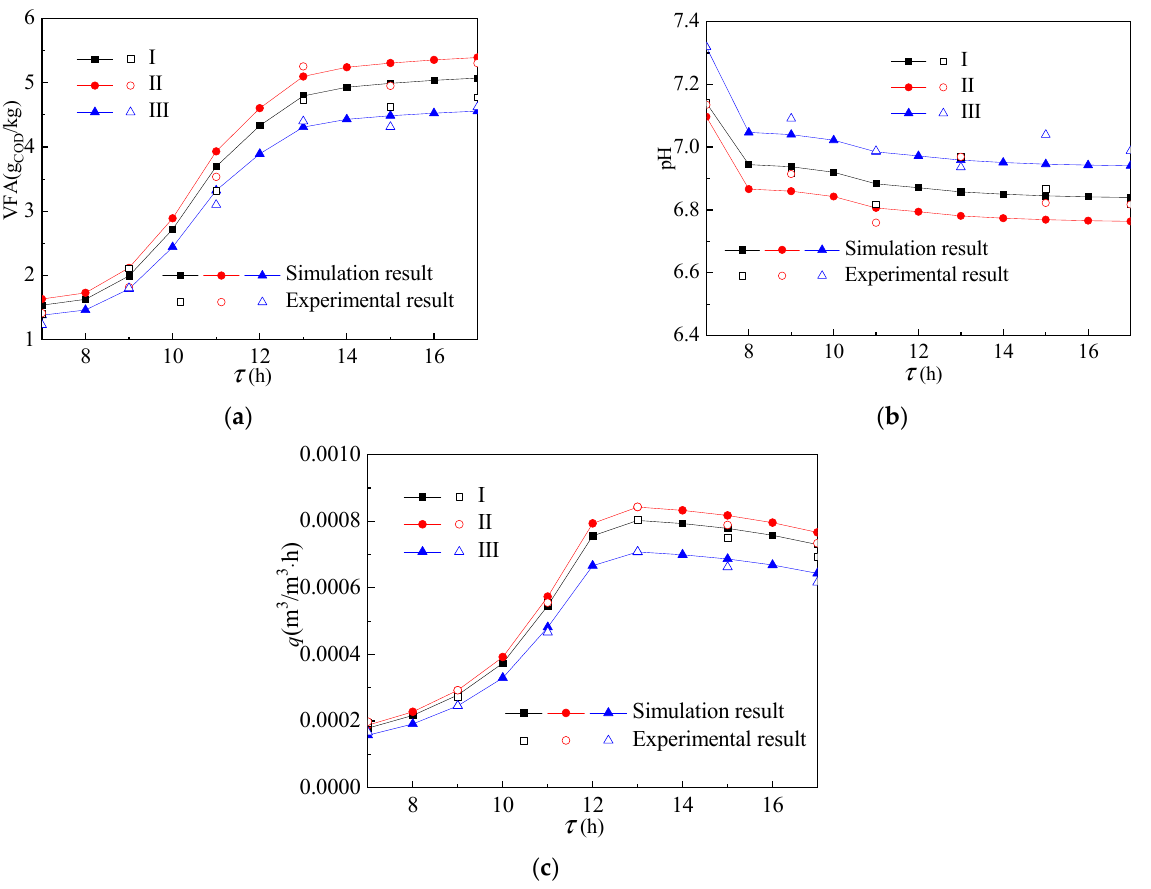
Figure 9. The change of ( a ) VFA, ( b ) pH, and ( c ) gas production of the reactants over